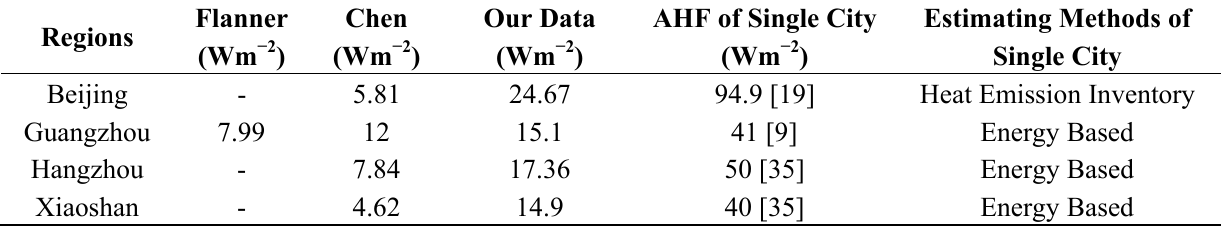
Table 1. The differences of our data and results of other’s